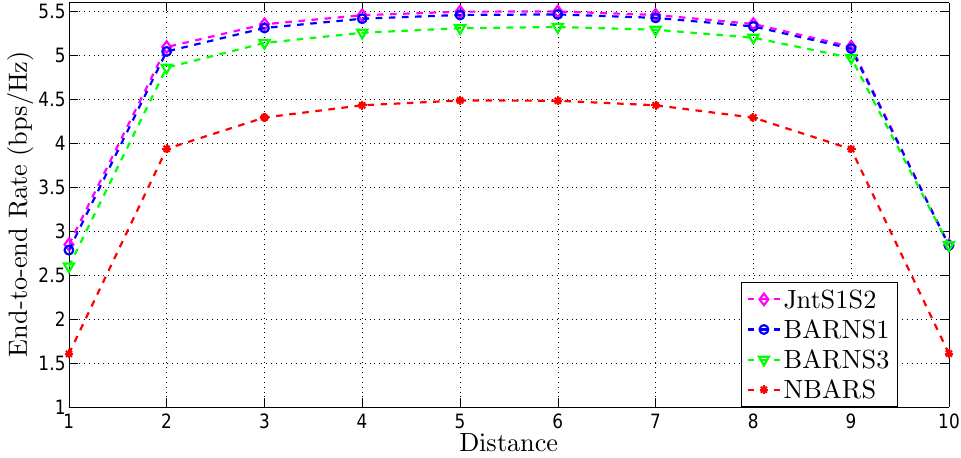
Figure 4. Throughput (bps/Hz) versus relay position (the distance of the relay from base station